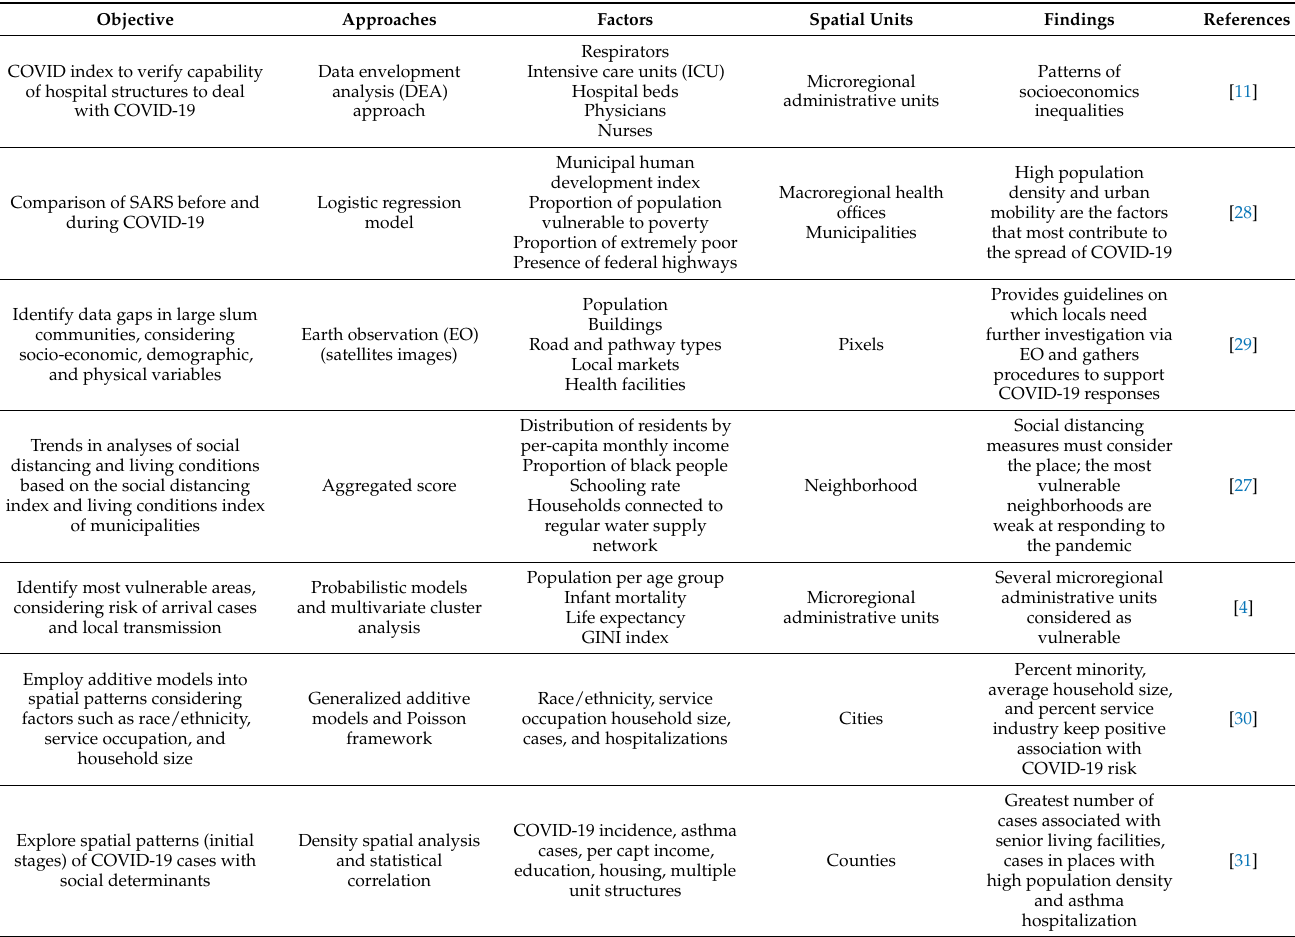
Table 1. Summary of Brazilian research papers correlating social, economic, and demographic aspects with